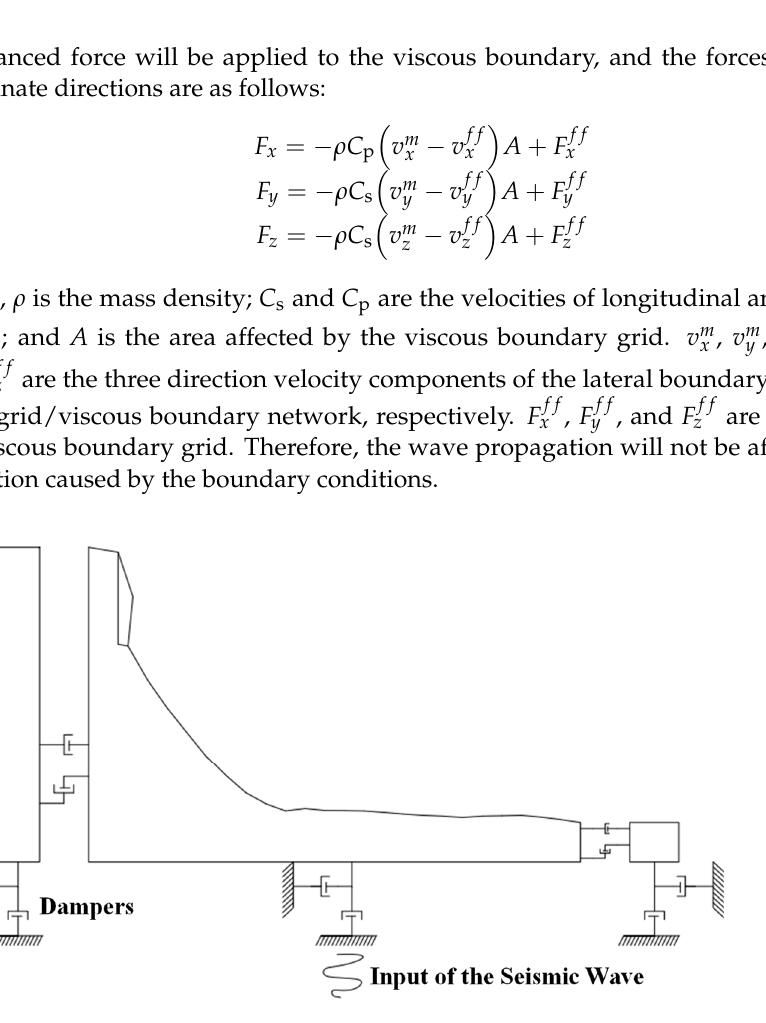
Figure 6. Dynamic viscous boundary condition.